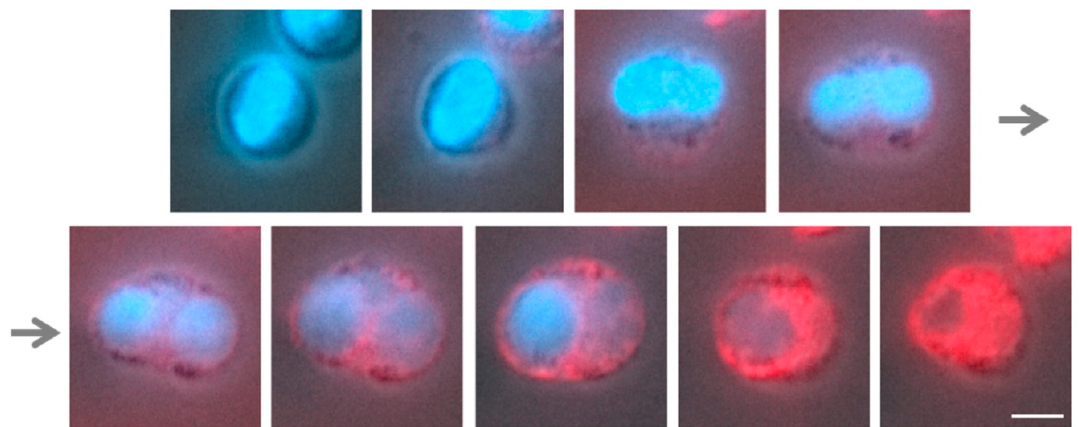
Figure 7. Release of NETs. NETosis stimulation was performed with 50 nM PMA. At the very beginning of PMA induction, a healthy cell with an intact nucleus is visible. Then DNA decondensation takes place, followed by disintegration of the nuclear membrane and a fusion of DNA with the released cytoplasmic proteins. Thus, at this time point, the cell dimension expands, leading to a rupture of the outer membrane, along with the release of the DNA-protein mixture into the fluid surrounding the cell. The empty cell membrane remains behind. The cell membrane (red) was stained with Deep Red and DNA (blue) with DAPI. Scale bar: 5 µm.